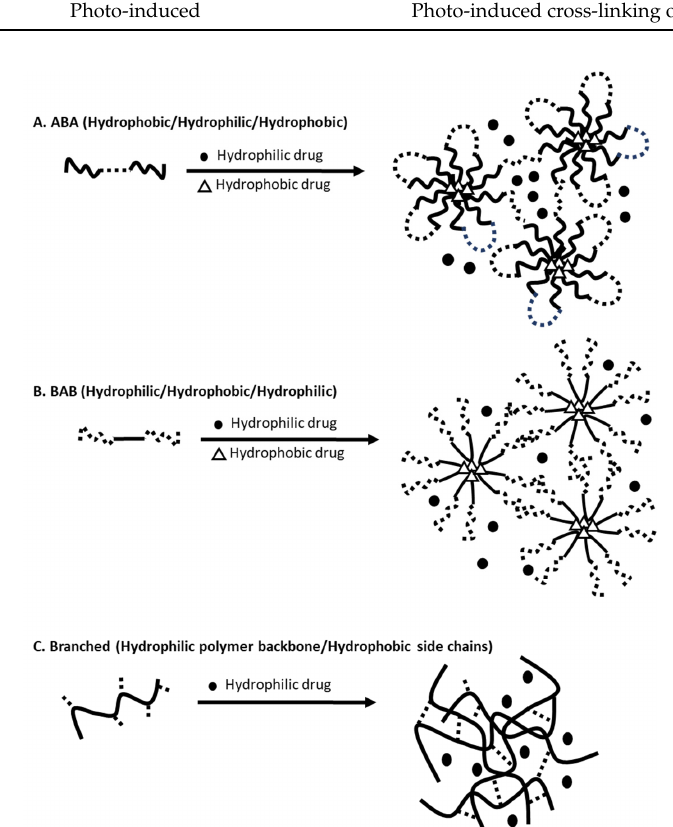
Figure 1. Illustrations of physically self-assembled nanogels loaded with hydrophilic (solid circle) and hydrophobic (empty triangle) drugs using ( A ) ABA, ( B ) BAB, and ( C ) branched polymers (modified from [50] ).